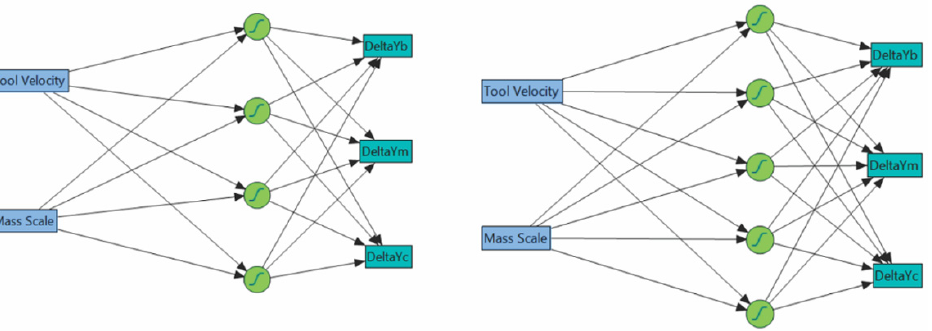
Figure 5. Neural network architectures for mesh size 1 × 1 mm ( left ), and mesh size 3 × 3 mm ( right ).